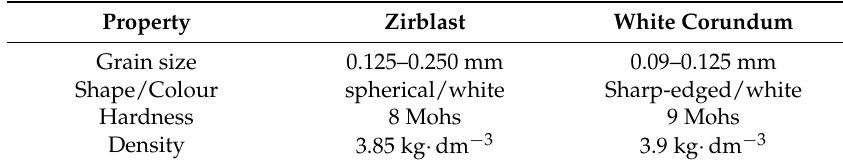
Table 2. Chemical composition of abrasives in wt. %. Table 3. Physical properties of